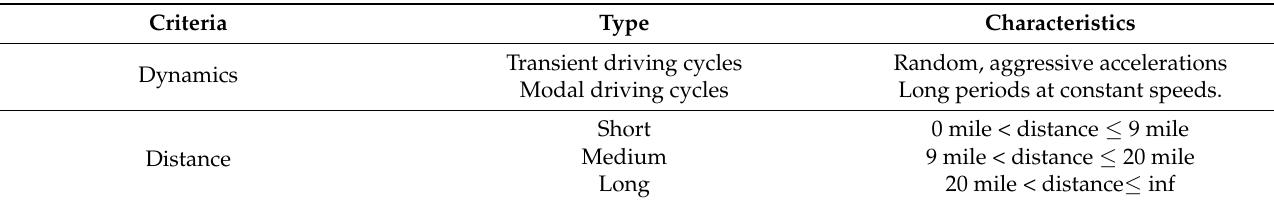
Table 1. Different driving cycle